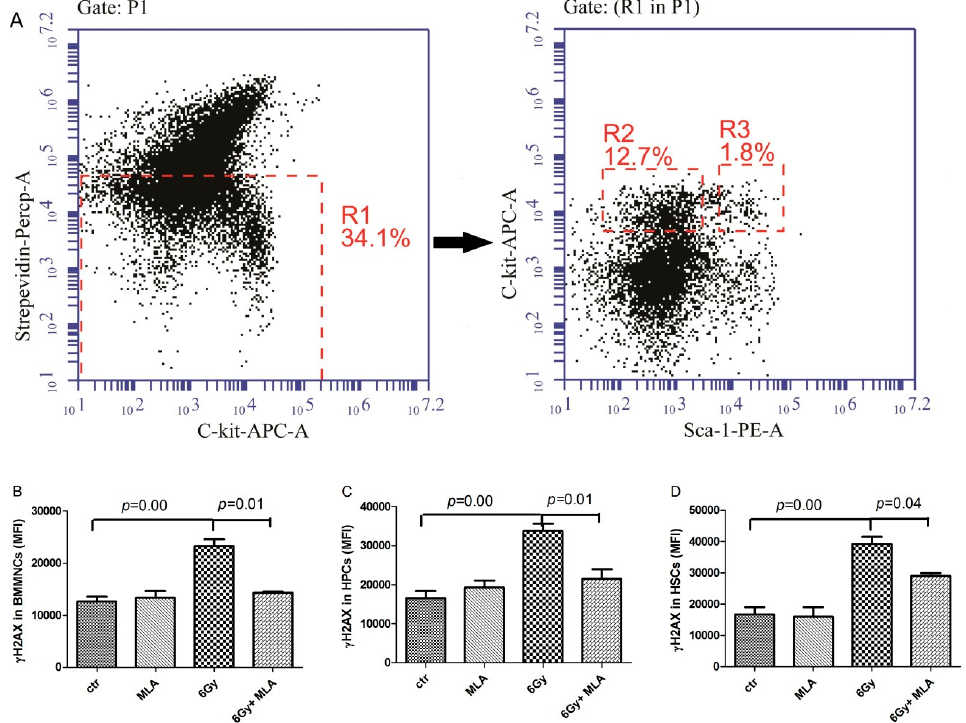
Figure 6. Effects of MLA on the H2AX phosphorylation. ( A ) A representative flow cytometry graph: